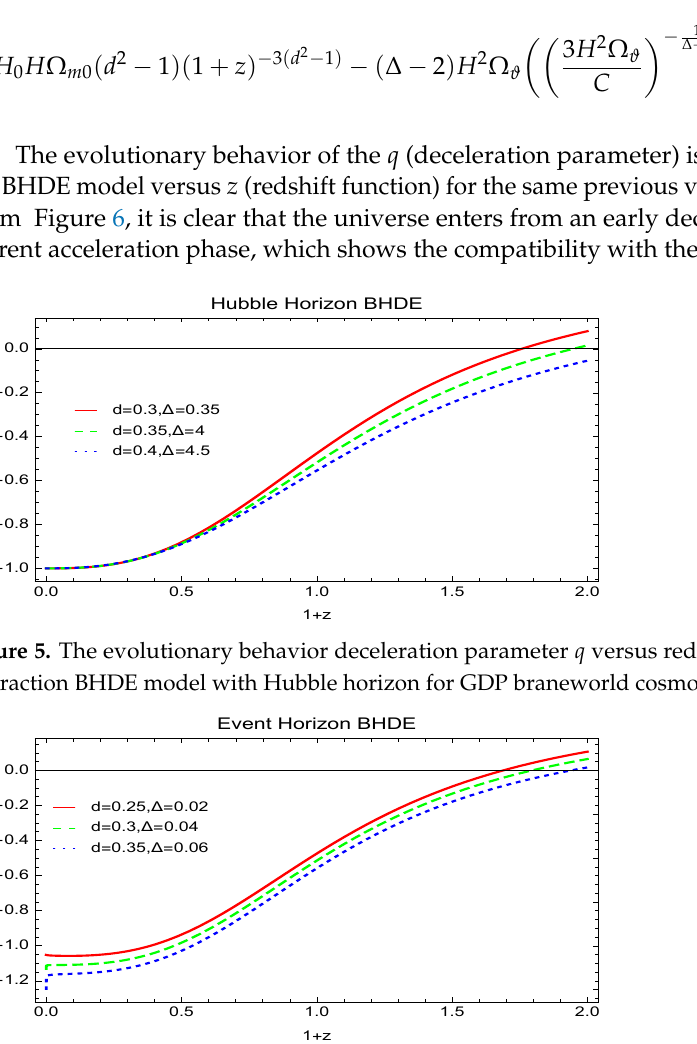
Figure 6. Plot of q versus 1 + z for BHDE model with event horizon for GDP braneworld